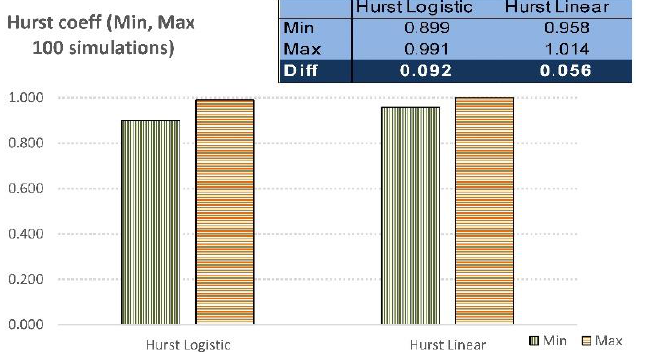
Figure 9. Min and max values of Hurst coefficient (logistic and linear variant). (Source: authors). Relatively small differences are given by masking the positive and negative deviations in the calculation of the arithmetic mean. The sum of the distances measured from the maximal limit of the Hurst coefficient means a more expressive description of the difference between the logistic and linear distribution of resources in production process activities. The higher the value is, the greater the total distance from the maximum H–coefficient, i.e., the extreme of deflection in the model of the implementation process (Table 3). Table 3. Sum of distances from max. Hurst coefficient. (Source: authors). Sum of Distances from Max. Hurst